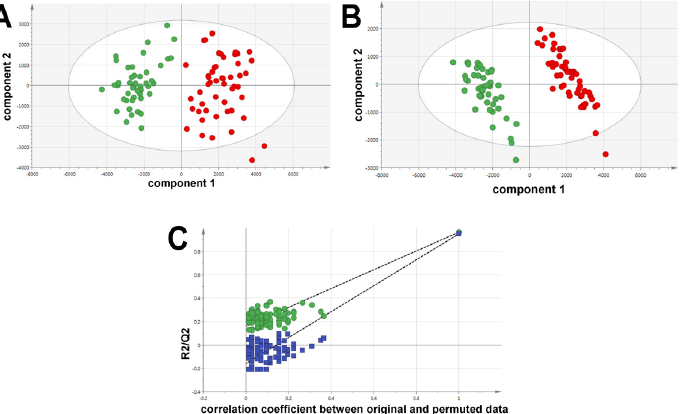
Figure 1. Multivariate data analysis of HCV-positive patient plasmas (red) and HCV-negative control plasmas (green). Samples were analyzed in duplicate. ( A ) PCA scores plot showing complete separation of the HCV-positive and negative plasmas. ( B ) PLS-DA scores plot showing enhanced resolution of the HCV-positive and negative plasmas. ( C ) Leave-one-out cross validation of the PLS-DA model with 200 permutations for R2 (green) and Q2 (blue).